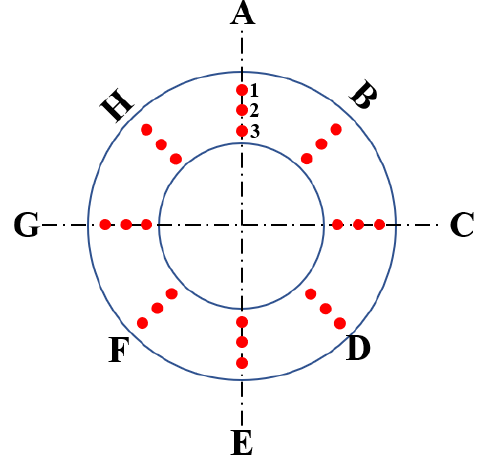
Figure 3. Hardness measurement point in A-H direction.